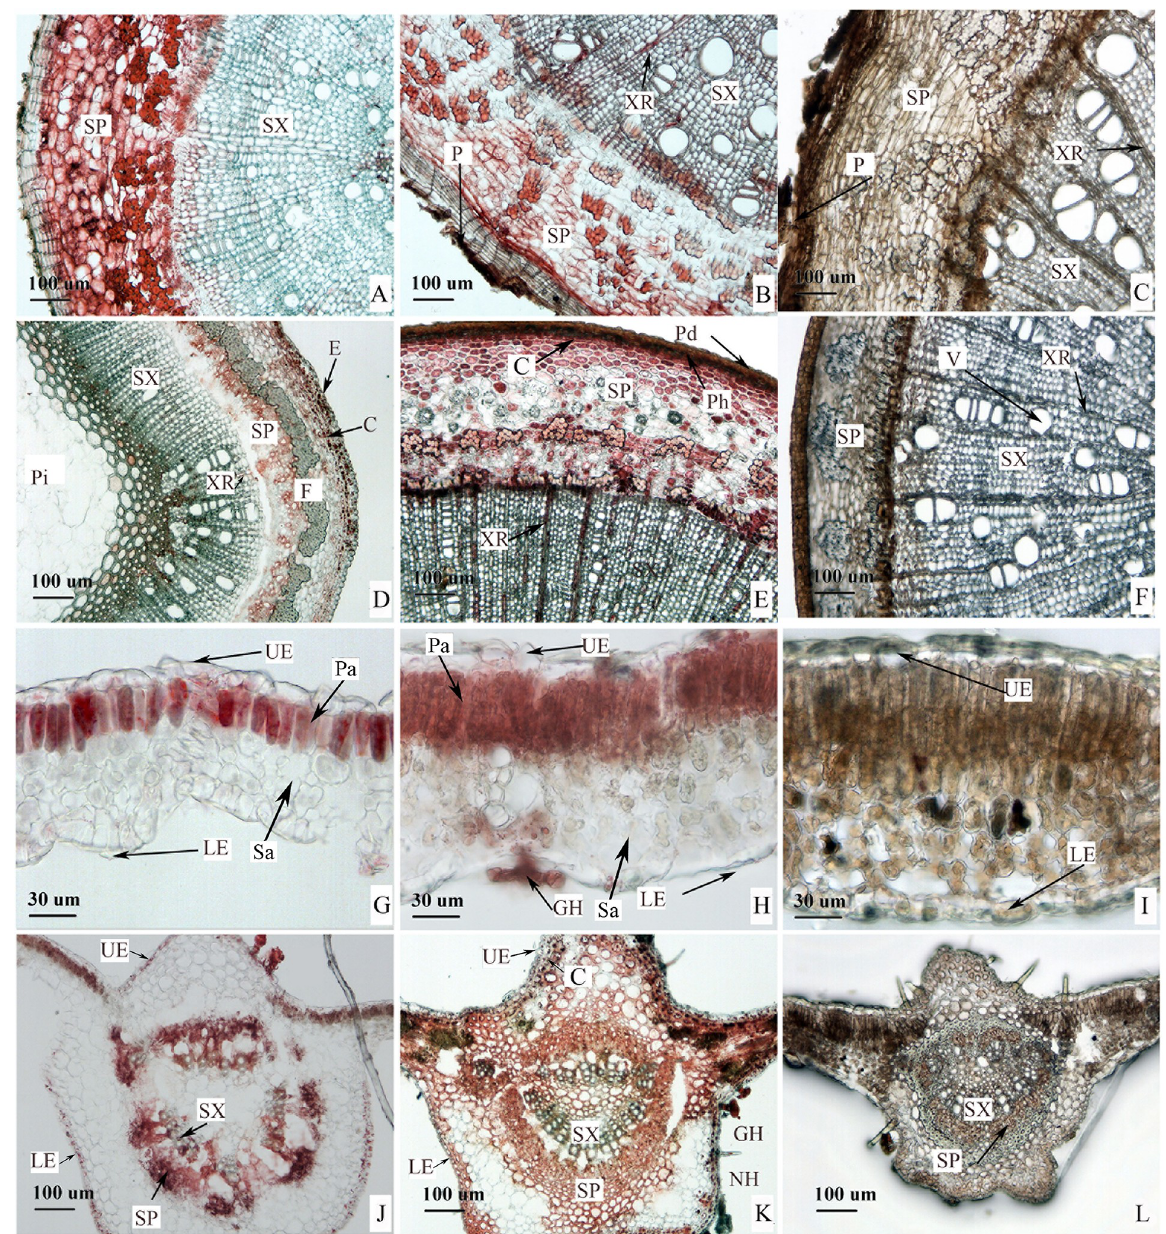
Fig 1. Histochemical localization of saponins in C . paliurus . ( A ) Cross section of new roots collected in April. Secondary phloem is displayed by deep red; ( B ) Cross section of mature roots collected in May. Phelloderm is indicated with a deep red, and secondary phloem and xylem ray are light red; ( D ) Cross section of shoots collected in May. Epidermis and cortex are indicated with deep red, and the phloem and xylem ray in light red; ( E ) Shoot collected in September. Phelloderm of periderm is in red; ( G ) Cross section of leaf (April). Mesophyll tissue is displayed by red, and epidermis is displayed by light red; ( H ) Cross section of leaf (June). Palisade parenchyma and glandular hair are deep red, while epidermis is light red; ( J ) Cross section of the midrib in tender leaf (May). Undifferentiated phloem is indicated with red; ( K ) Cross section of the midrib in mature leaf. Upper epidermis and cortex are indicated with deep red (May); ( C , F , I , L ) The control sample of root, shoot, leaf and midrib, respectively. GH, Glandular hair; LE, Lower epidermis; NH, Nonglandular hair; SP, Secondary phloem; SX, Secondary xylem; UE, Upper epidermis; C, Cortex; E, Epidermis; F, Fiber; P, Periderm; Pd, Phelloderm; Ph, Phellem; Pi, Pith; XR, Xylem ray; Pa, Palisade tissue; Sa, Spongy parenchyma.